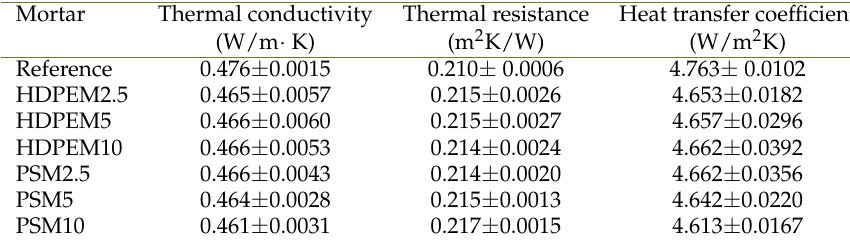
Table 4. Properties of wall plastered with the mortar blended plastic waste